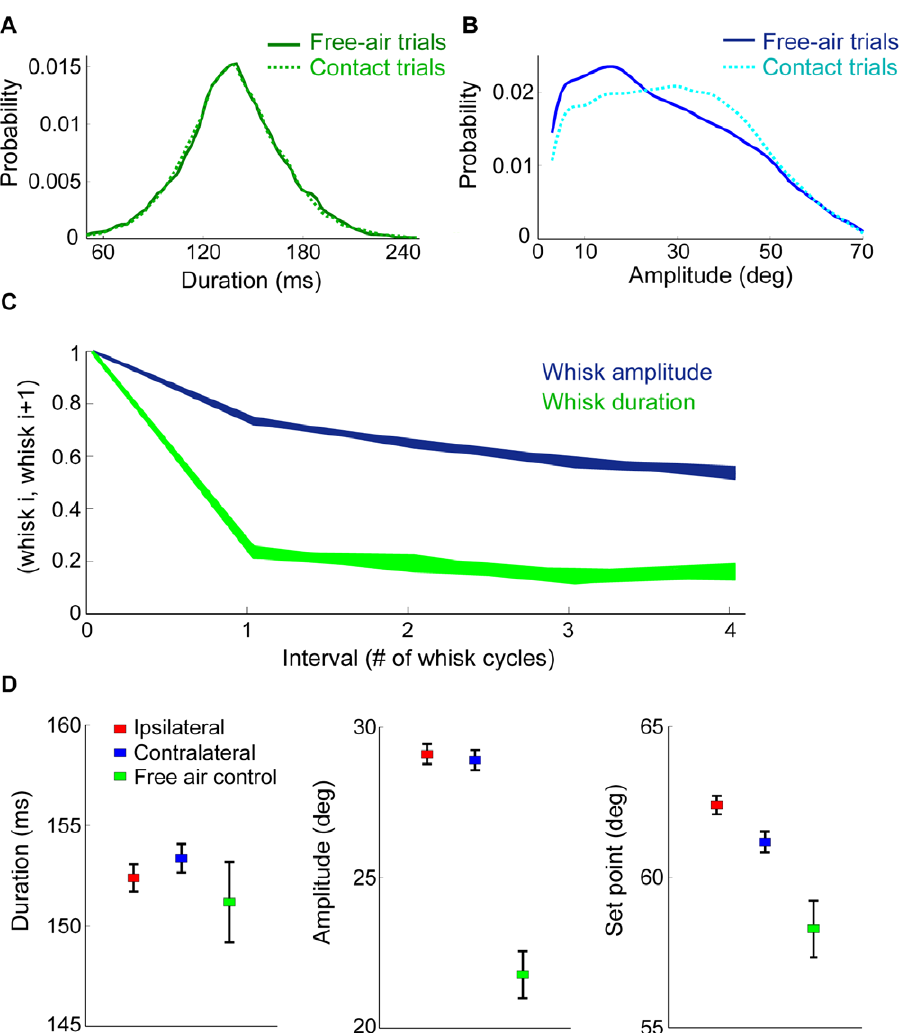
Figure 6. Whisking kinematics in free-air and after contact. A. Distribution of whisk duration in free-air (dark green) and in contact (light green) trials. B. Distribution of whisk amplitudes in free-air (dark blue) and contact (light blue) trials. The distributions in A and B where smoothed using the MATLAB function fitdist (‘kernel’, width=2). C. Correlations between the amplitude and duration of pairs of whisks, as a function of the interval between them. D. Whisk duration, amplitude, and set point, before the first ‘‘pseudo touch’’ (free-air trials; green) and the first (real) touch (contact trials; red for the ipsilateral and blue for contralateral sides).